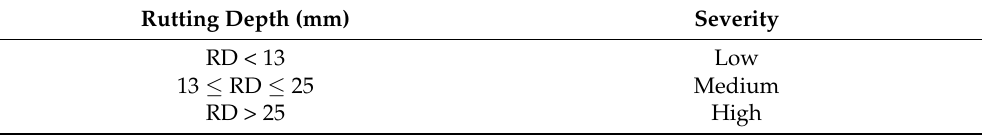
Table 2. Severity thresholds of rutting depths [21].